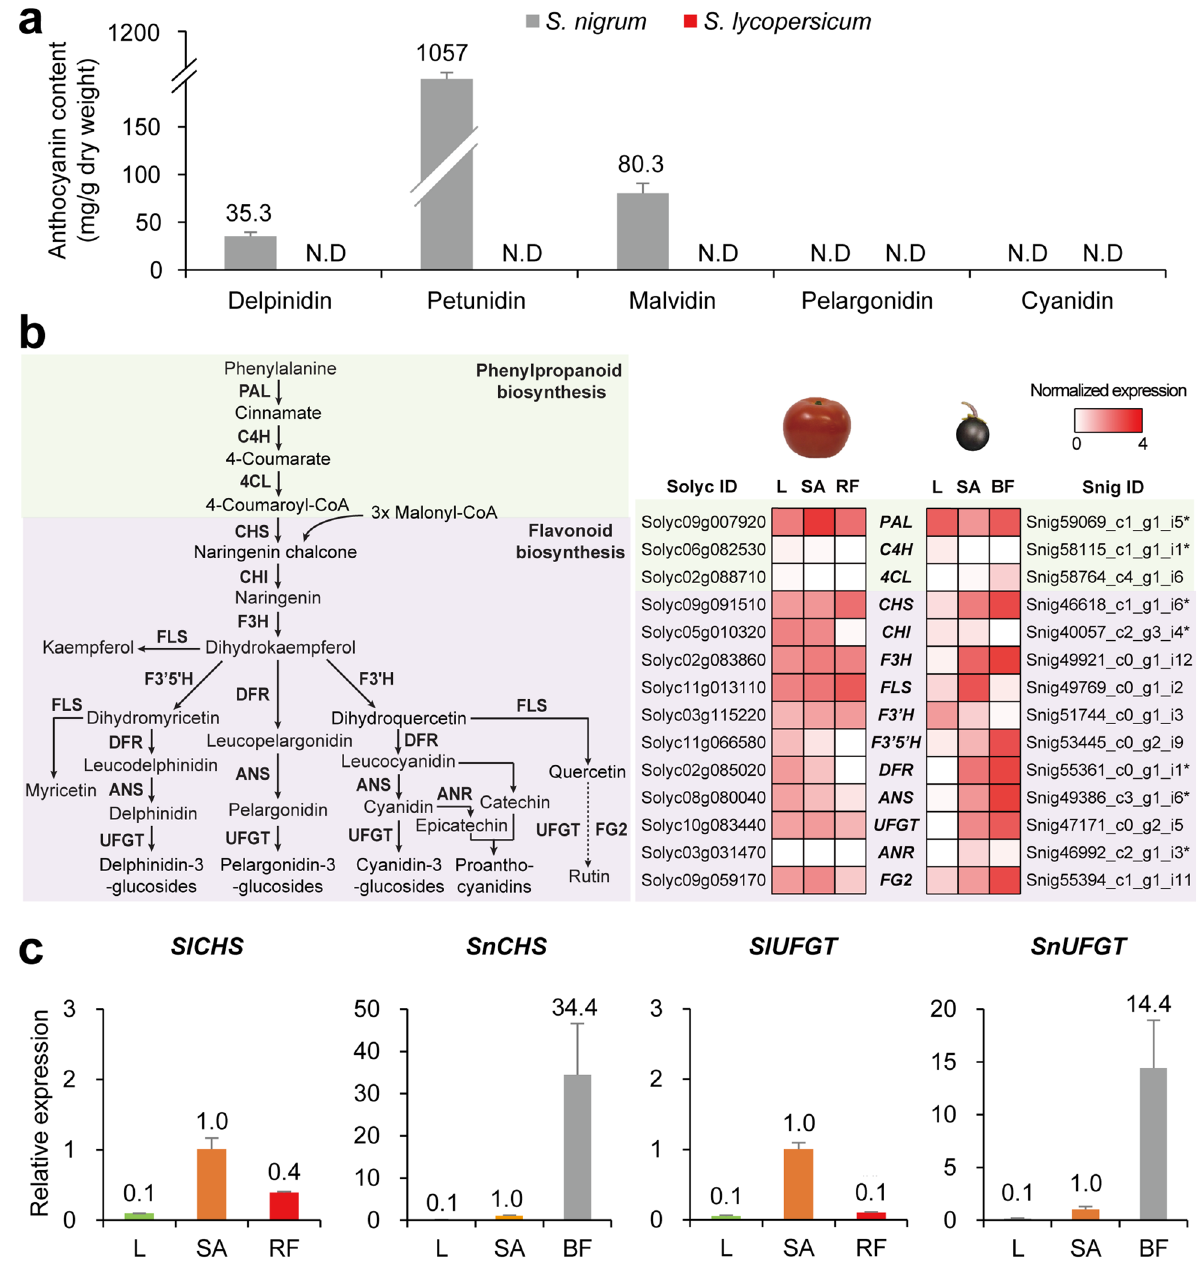
Figure 5. Comparison of metabolites and expression profiles in flavonoid biosynthesis pathway. ( a ) Flavonoid contents in mature fruits of S. nigrum and S. lycopersicum . Data are shown as mean ± standard deviation: n = 5; five technical replicates, a minimum of 50 fruits were pooled. N.D, not detected. ( b ) Flavonoid biosynthesis pathway and expression profiles of flavonoid biosynthetic genes. Dotted arrow indicates the condensed pathway. S. nigrum unigenes with asterisk represent genes with highest homology. The expression is normalized by log 10 (TPM + 1). ( c ) qRT-PCR results for CHS and UFGT between the two species. Expression levels of each gene were normalized with the value of shoot apex and UBIQUITIN was used as the endogenous control. Data are shown as mean ± standard deviation: n = 2, pooled samples and two technical replicates. L, leaf; SA, shoot apex; RF, red fruit; BF, black